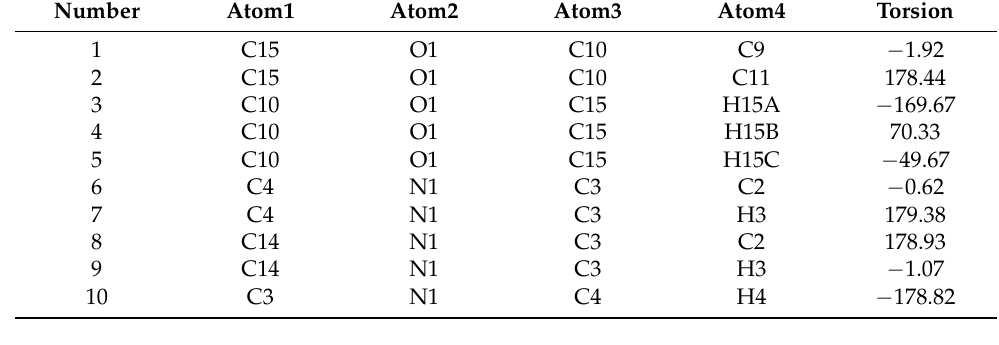
Figure 3. ORTEP Diagram for MMPI. Table 3. Selected torsion angle for MMPI crystal.